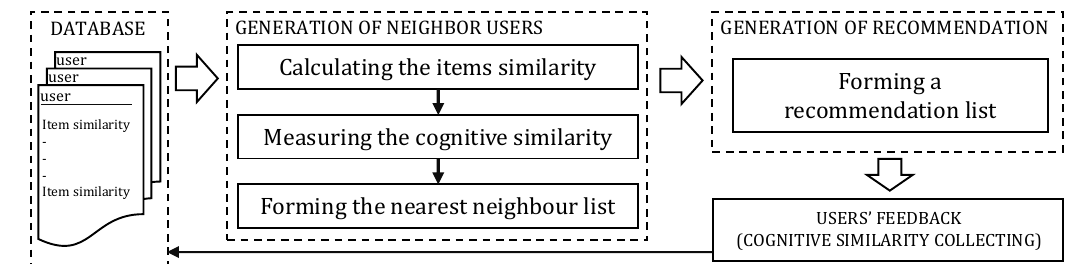
Figure 4. The process of recommendation